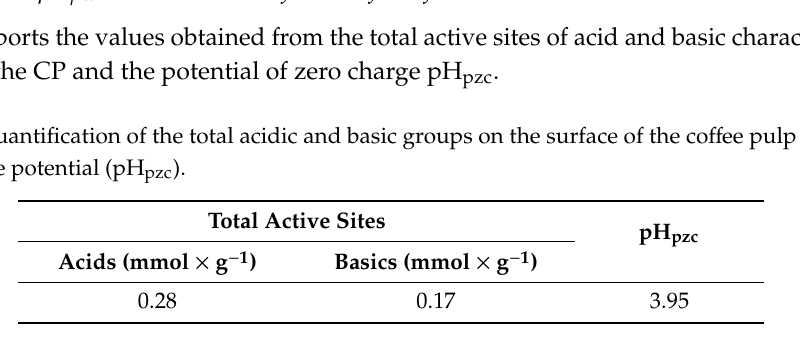
OH: coming from the lignin and cellulose